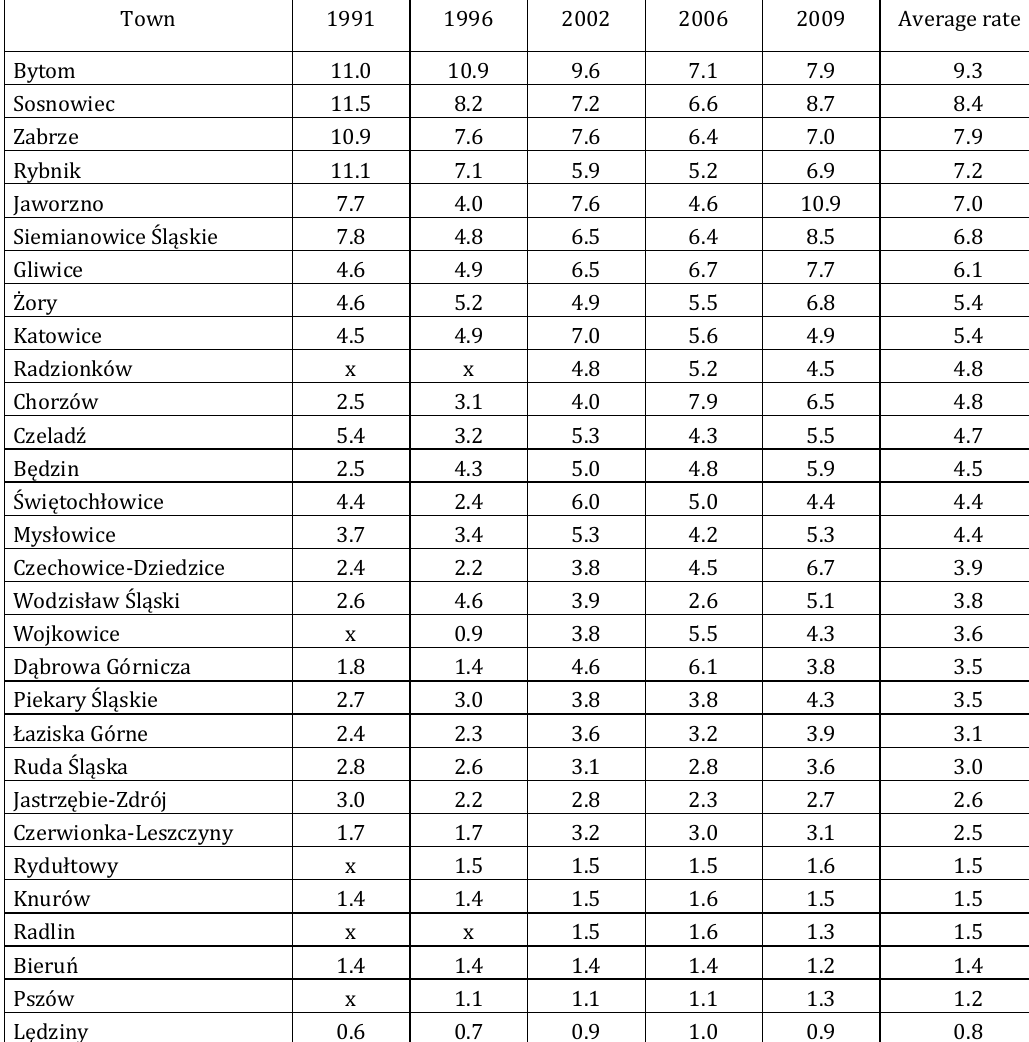
Table 1. Changes of the economic base rate of mining towns in the Silesian voivodeship (author’s compilation)